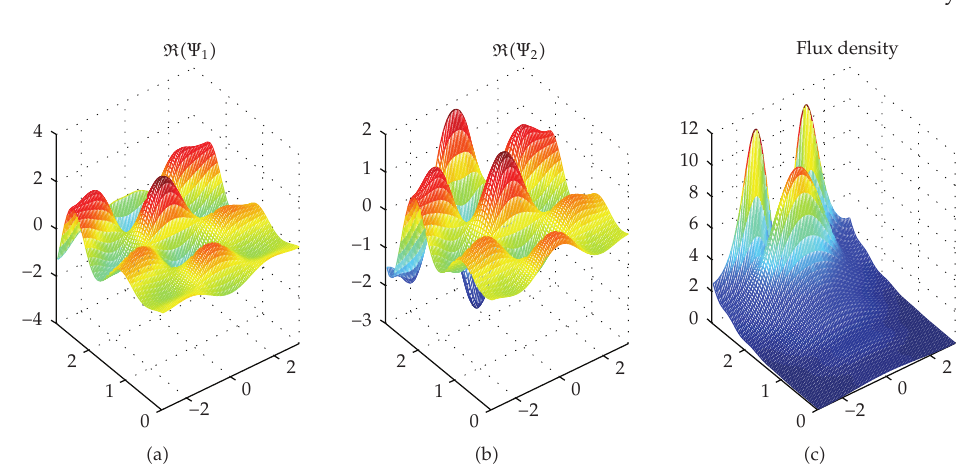
(cid:7) x, 0 (cid:8) (cid:6) 0 . 3exp (cid:7) ix (cid:8)(cid:9) 0 . 2 ∗ exp (cid:7) 2 ix (cid:8) , ψ 2